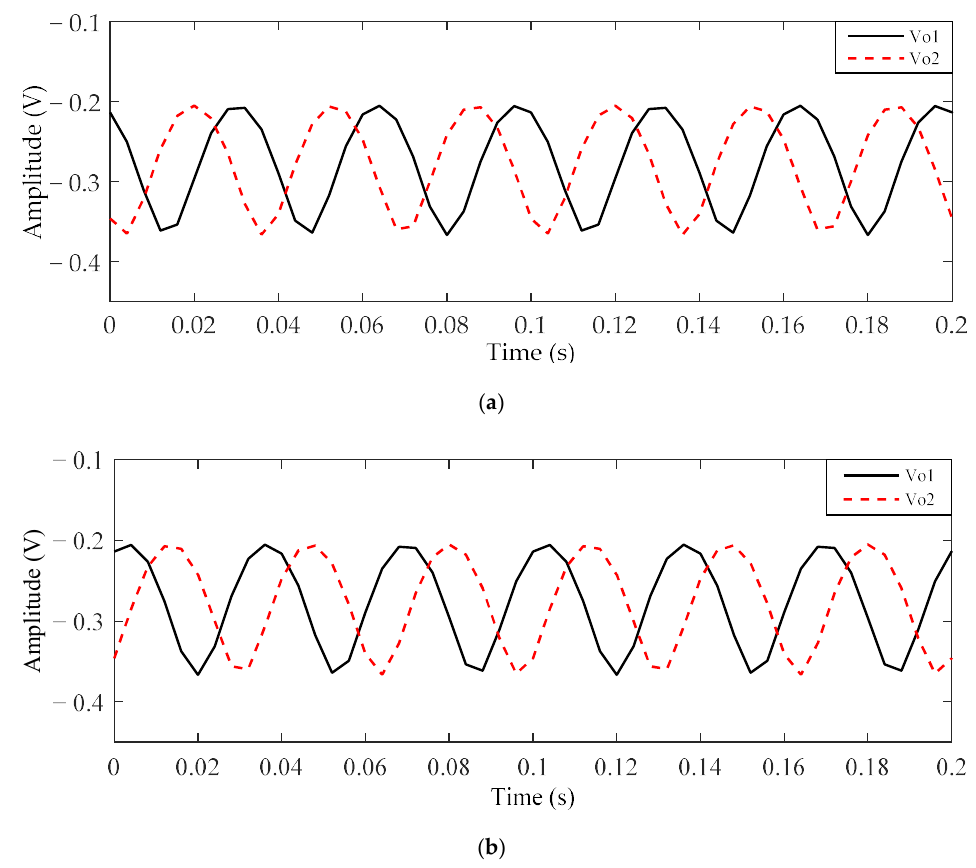
Figure 6. The ideal output signals of V o1 and V o2 for d = 6 cm: ( a ) signals V o1 and V o2 obtained when the rotor rotates clockwise; ( b ) signals V o1 and V o2 obtained when the rotor rotates anticlockwise.